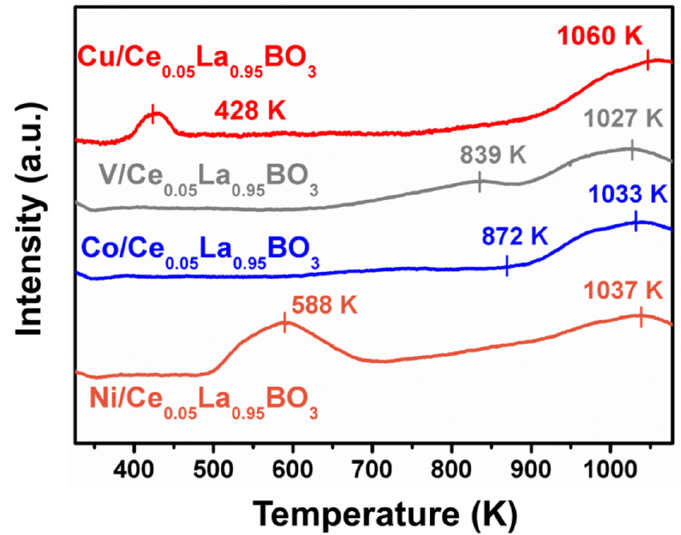
Figure 7. H 2 -TPR profiles of Cu/Ce 0.05 La 0.95 BO 3 , Ni/Ce 0.05 La 0.95 BO 3 , Co/Ce 0.05 La 0.95 BO 3 , and V/Ce 0.05 La 0.95 BO 3 .